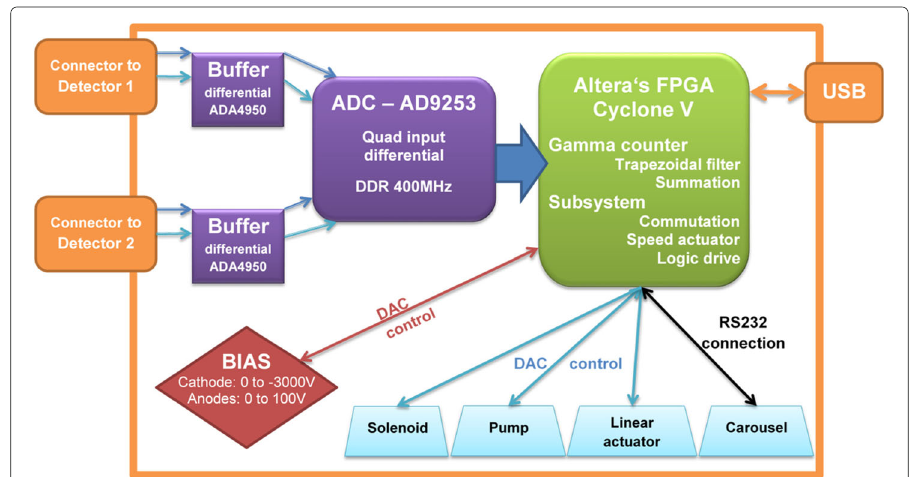
Fig. 4 Signal workflow and connection diagram. The FPGA listens to the USB port and executes commands sent by the GUI